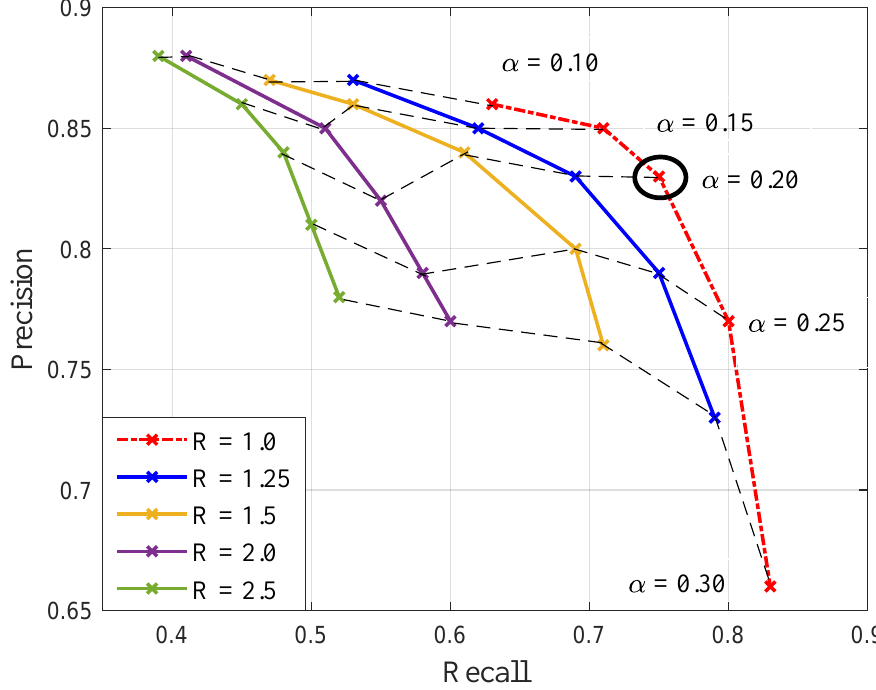
Figure 10. Performances of the reconstruction of downy mildew foliar symptoms for 100 images, depending on the pairs of relaxed thresholds ( R min , α ) from seeds determined with [ R min = 2.5, α = 0.1 ]